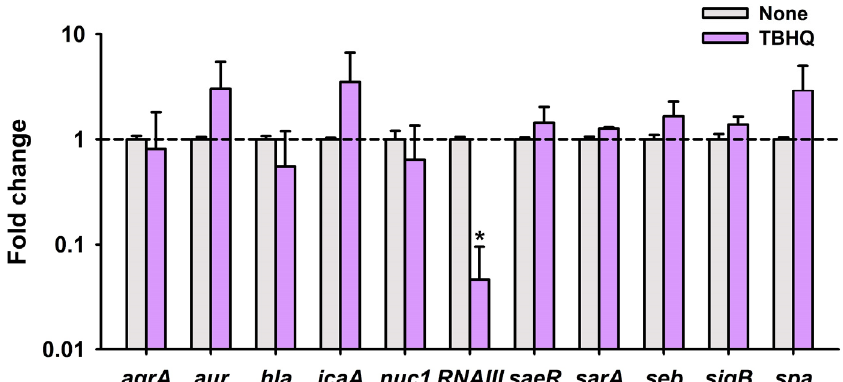
Figure 4. Transcriptional profiles of S. aureus cells treated with or without TBHQ. MSSA 6538 was cultivated for 3 h with shaking at 250 rpm and then incubated with or without TBHQ (1 µg/mL) for 4 h with shaking at 250 rpm. Transcriptional profiles were measured by qRT-PCR. Fold change represents transcriptional changes vs. non-treated S. aureus . The experiment was performed in duplicate. * p < 0.05 vs. non-treated controls (None).